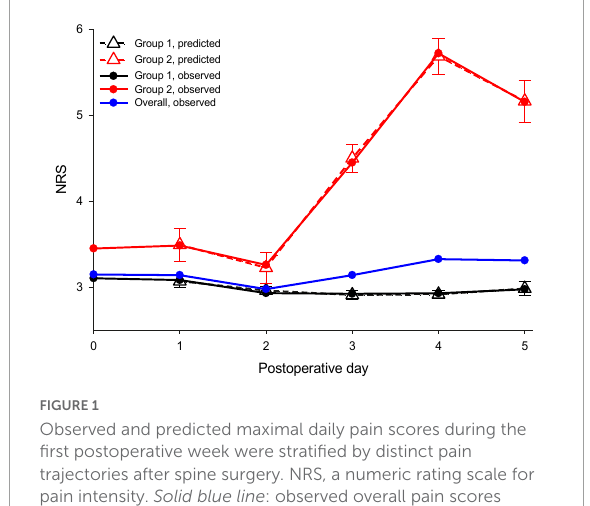
FIGURE1 Observed and predicted maximal daily pain scores during the first postoperative week were stratified by distinct pain trajectories after spine surgery. NRS, a numeric rating scale for pain intensity. Solid blue line : observed overall pain scores during the first postoperative week; solid black line : observed pain scores of the mild pain trajectory group; solid red line : observed pain scores of the rebound pain trajectory group; dashed black line: predicted pain scores with their 95% confidence interval ( CI ) for the mild pain trajectory group; and dashed red line : predicted pain scores with their 95% confidence interval for the rebound pain trajectory group.